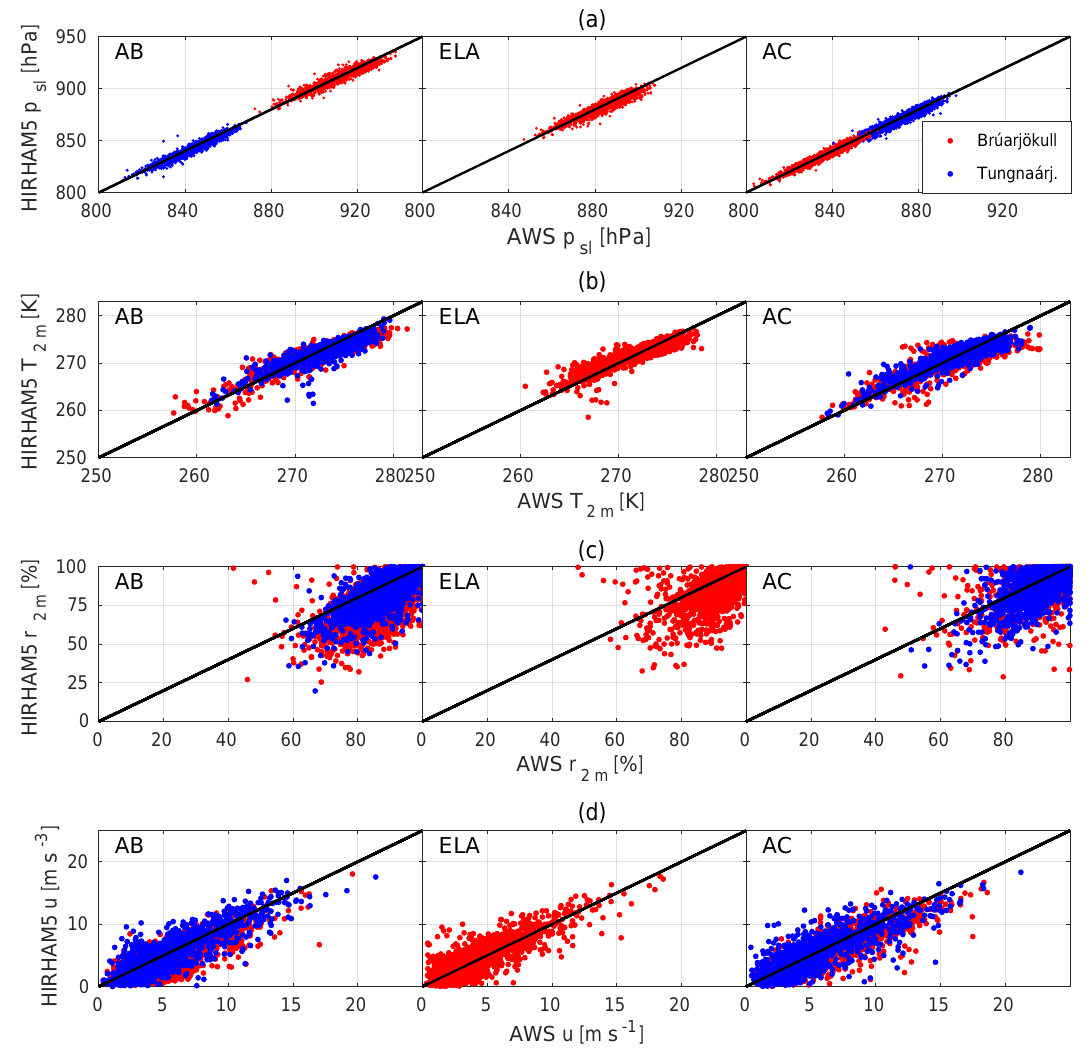
Figure 2. Scatter plots of the measured (a) surface pressure, (b) , air temperature at 2m, (c) relative humidity at 2m, and (d) wind speed at 2m, by stations on Bruarjökull (red) and Tungnaárjökull (blue) versus the same components simulated by HIRHAM5 at the same